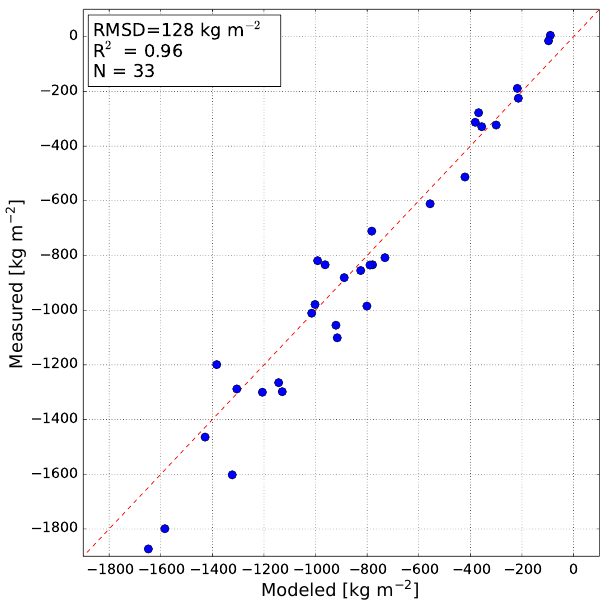
Figure 7. Scatter plot of modeled annual point mass balances against observations.